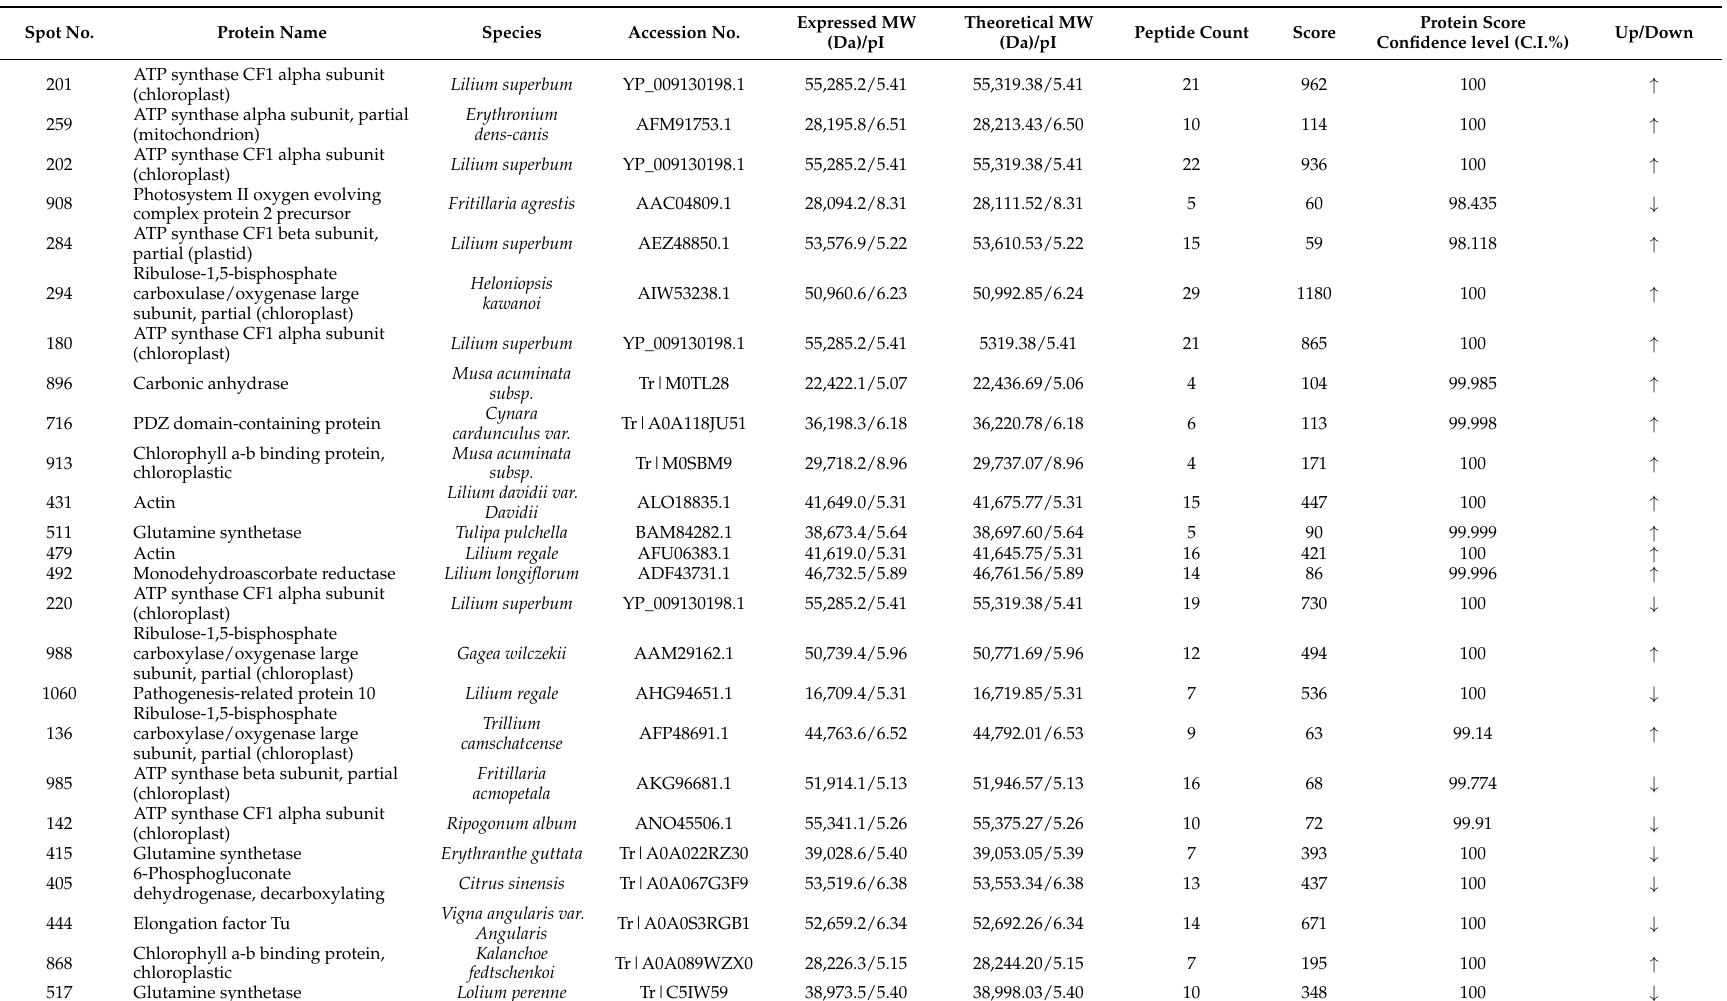
Table 1. Identification and analysis of proteins in leaves of cut lily after HRW, SNP, and HRW plus NaN 3 or tungstate treatment. Spot